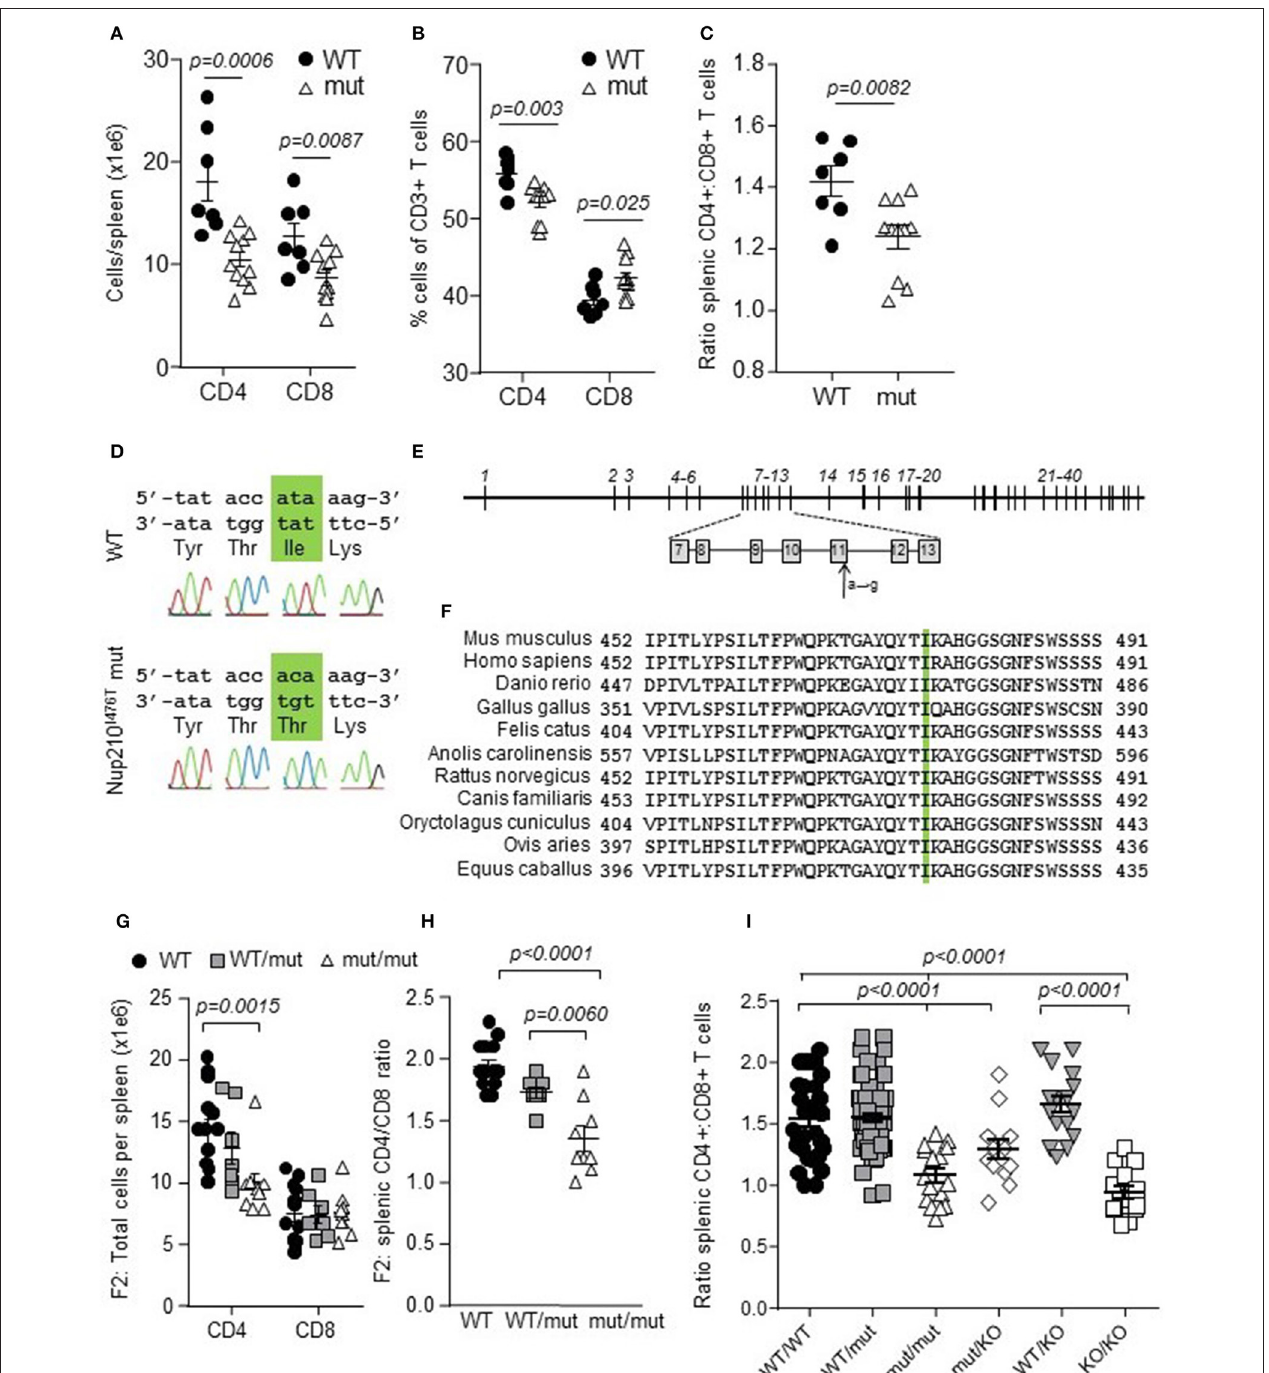
FIGURE 1 | Altered ratio of peripheral CD4:CD8T cells in Nup210 mutant mice. ENU mutagenesis generated a Nup210 I 476 T mouse strain, identified by peripheral blood screening for T cell composition. (A) Absolute numbers of cells in spleens from 5 to 6 week old wildtype (WT) and Nup210 I476T mutant (mut) mice. (B) Percent of splenic CD4 and CD8T cells assessed by flow cytometry. (C) Ratio of splenic CD4 and CD8T cells ( n = 7, 11). (D) Sanger sequencing of Nup210 in WT and Nup210 I476T mutant mice confirmed an A to G mutation, resulting in an isoleucine to threonine change at amino acid 476. (E) Schematic overview of the 40 exons of the Nup210 gene, including the location of the I476T mutation in exon 11 (arrow). (F) Conservation of the mutation site between the mouse, human, zebrafish, chicken, cat, lizard, rat, dog, rabbit, sheep, and horse homologous sequences. (G,H) Confirmation of germline transmission of the Nup210 I 476 T mutation in F2 offspring of the Nup210 I 476 T mutant founder mouse and resulting splenic phenotype in absolute cell numbers per spleen (G) and CD4:CD8 ratio (H) ( n = 14, 7, 9). (I) Replication of the Nup210 I 476 T mutant phenotype (spleen) in a complementation cross ( n = 33, 71, 16, 16, 20, 17). Mean ± SEM, with individual biological replicates.